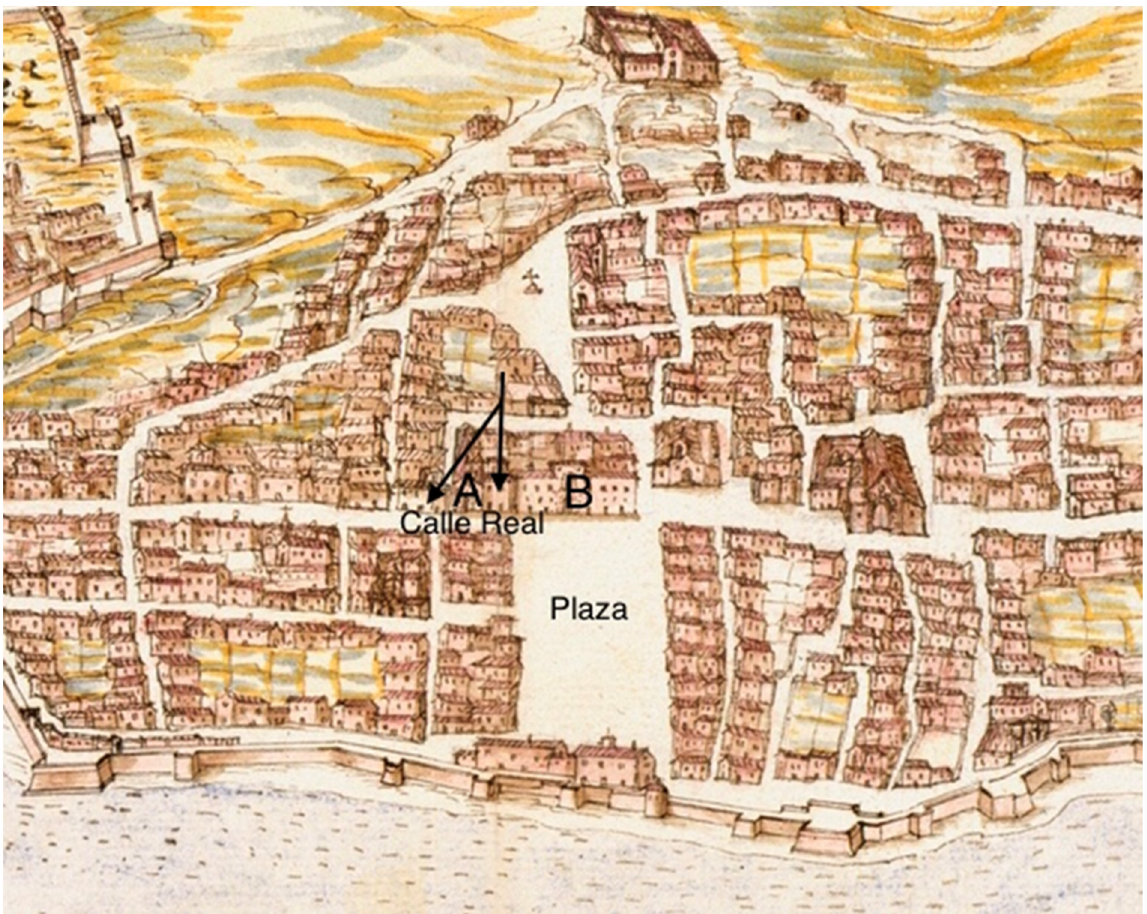
Figure 9. Annotated detail from Luis Bravo de Acuña’s 1627 plan of Gibraltar. Key: A = la Vera Cruz; B = la Misericordia. The arrows point to structures which are possibly the houses in question. British Library, London, Cartographic Items Additional MS 15152, f. 23r [© British Library, London].